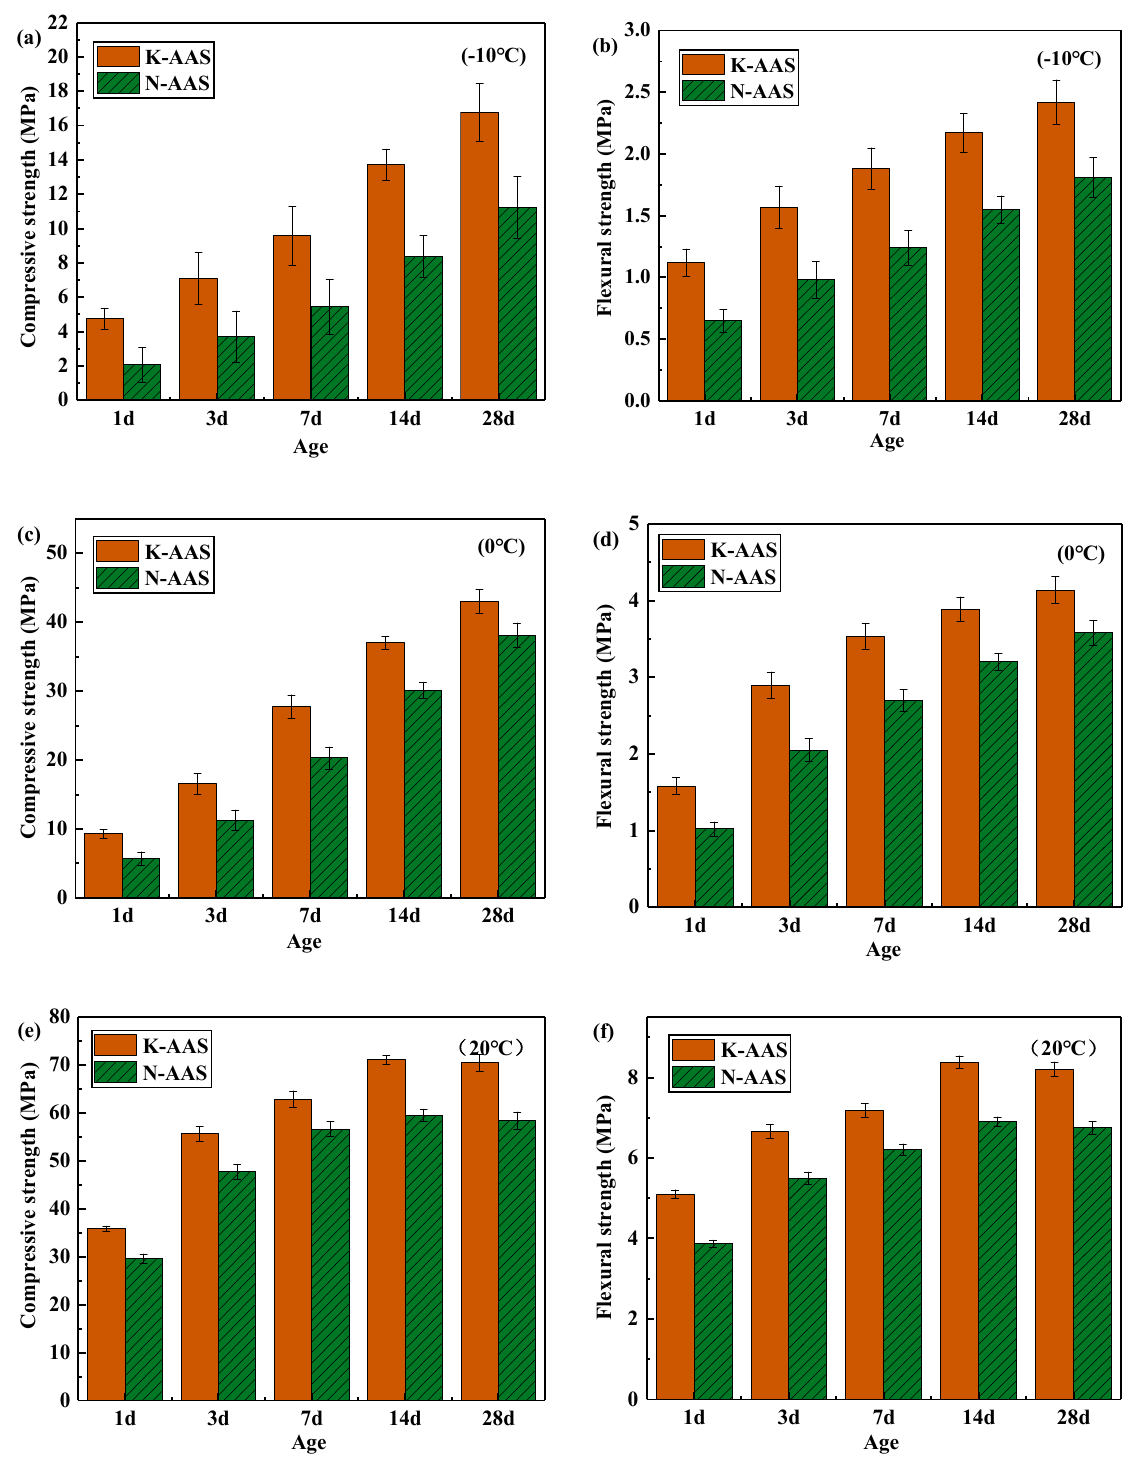
Figure 3. Compressive and flexural strengths of AAS mortar at different curing temperatures: ( a ) and ( b ) at − 10 °C, ( c ) and ( d ) at 0 °C, ( e ) and ( f ) at 20 °C.